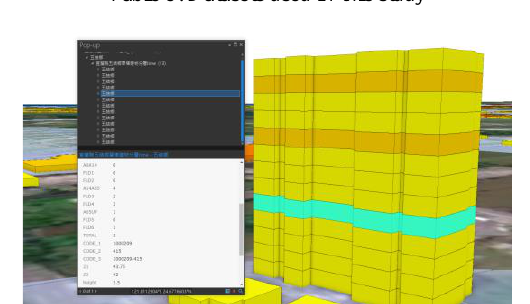
Figure 5. Attribute information relationship of hierarchy